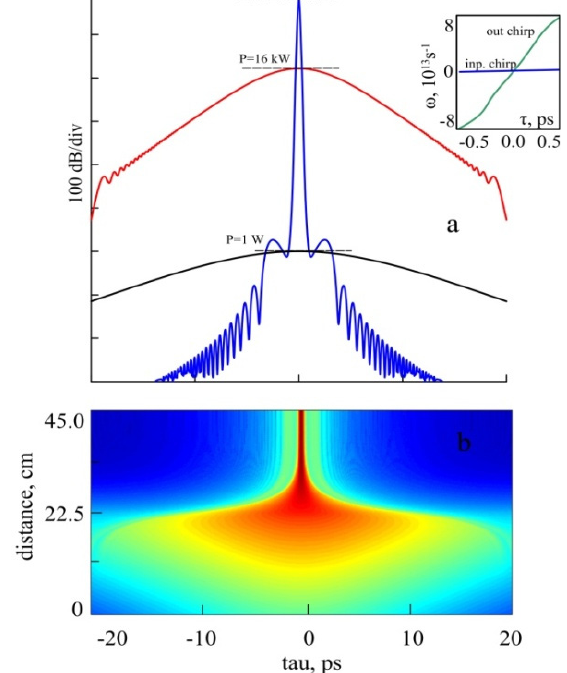
Figure 4. Temporal compression of FM pulse in the cascaded fiber configuration comprising one 10 ps τ = , initial power 1 W P = , initial active and one passive fiber. The parameters, duration 0 0 10 s α − = , nonlinearity 1 10 (W m) R − − = × , and dispersion profile are frequency modulation 24 2 fiber. The parameters, duration τ 0 = 10ps, initial power P 0 = 1W, initial frequency modulation 0 α 0 = 10 24 s − 2 , nonlinearity R = 10 − 5 ( W × m ) − 1 , and dispersion profile are shown in Figure shown in Figure 3.